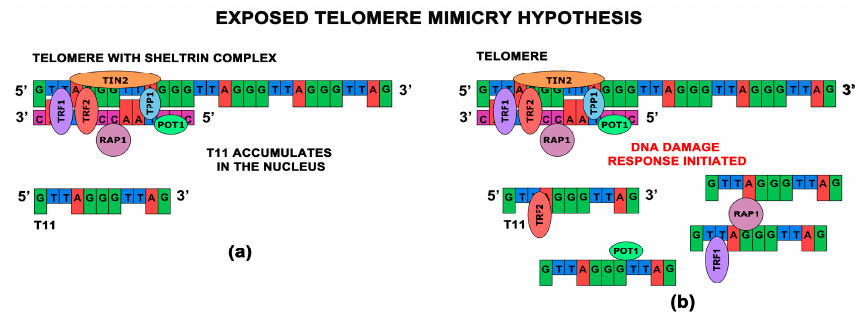
Figure 3. ( a ) The exposed telomere mimicry model hypothesizes that exogenous T11 mimics the exposed endogenous telomere overhang; ( b ) The cell responds to this mimicry of the telomere overhang exposure by initiating DDRs in cancer cells and triggering upregulation of shelterin proteins in attempt to overcome apparent telomere exposure.